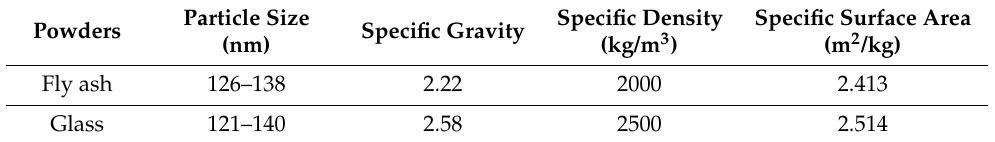
Table 2. The particle size of glass and fly ash